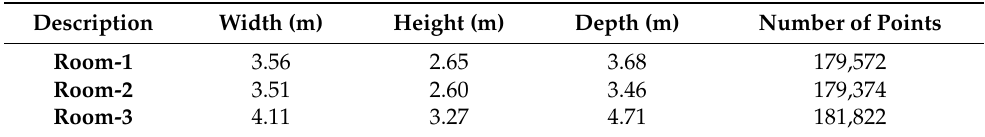
Table 3. Parameters of the datasets.